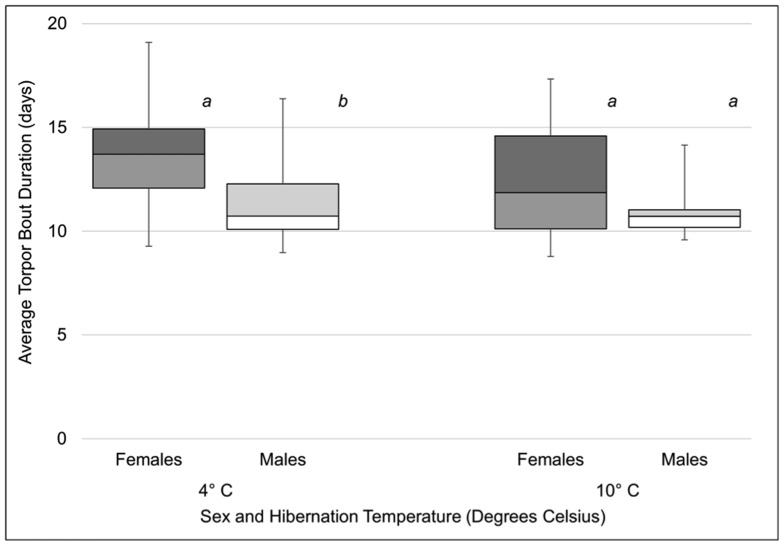
Average duration of torpor bouts (days) of male and female little brown myotis (Myotis lucifugus) not inoculated with Pseudogymnoascus destructans (Pd) and hibernated at either 4 or 10°C.Within each temperature, sexes not sharing common superscript letters were significantly different (P<0.05).